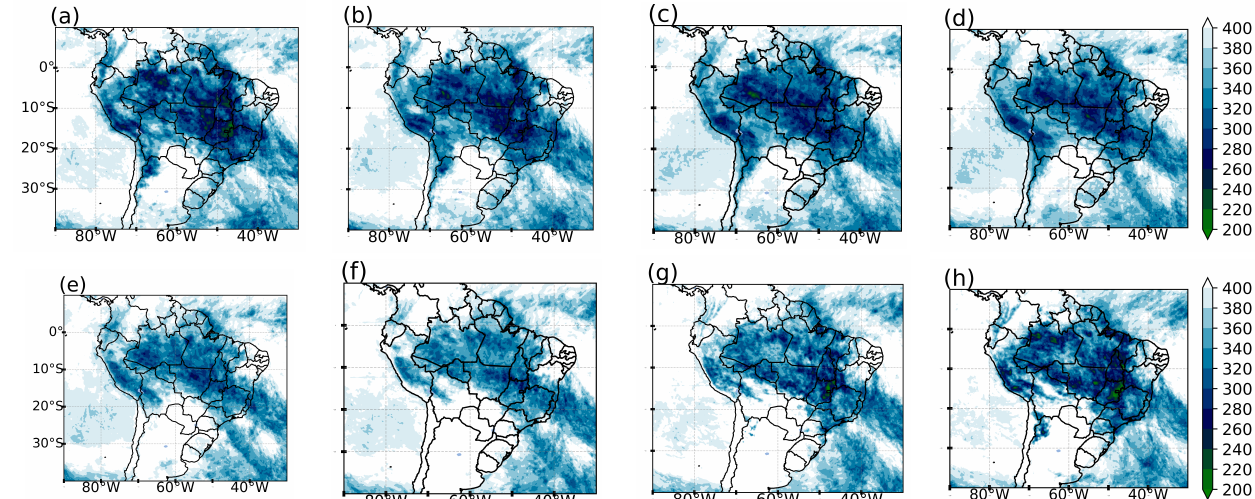
Figure 10. Composites of the diurnal spatial cycle of the OLR to ( a ) 00 UTC, ( b ) 03 UTC, ( c ) 06 UTC, ( d ) 09 UTC, ( e ) 12 UTC, ( f ) 15 UTC, ( g ) 18UTC, and ( h ) 21UTC of the SACZ events during the transition phase of the